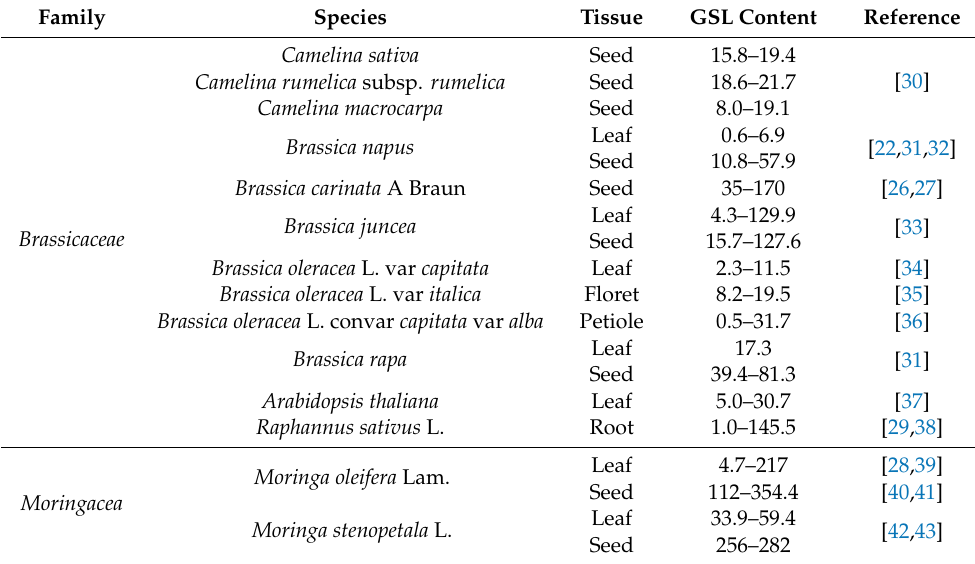
Table 1. Occurrence of GSL in plants of order Brassicales . GSL concentration is expressed as a minimum–maximum in µ mol / g of dry material.